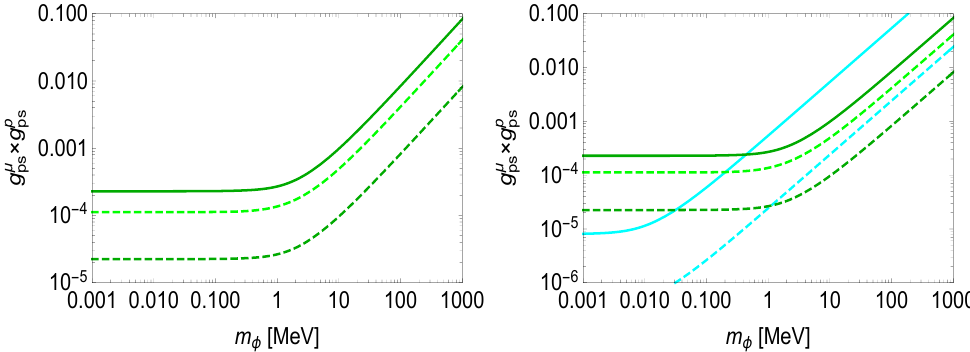
Figure 5 . Left plot: sensitivity to a light axion-like particle coupled to muons and protons of the µ H HFS measurements and projections. The dark green curves correspond to the 2 s HFS present (solid) and future (dashed) bounds, while the light dashed green to the future 1 s HFS FAMU measurement, see table 2. Right plot: we consider a scenario where g e = g µ m e measurements to the 2 s HFS on regular hydrogen (cyan, solid present and dashed